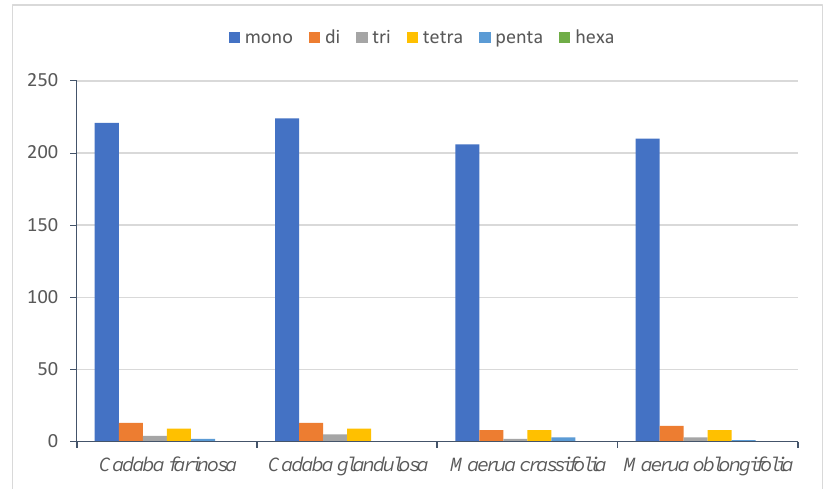
Figure 5. Number of different SSR types in the four chloroplast genomes of Capparaceae.